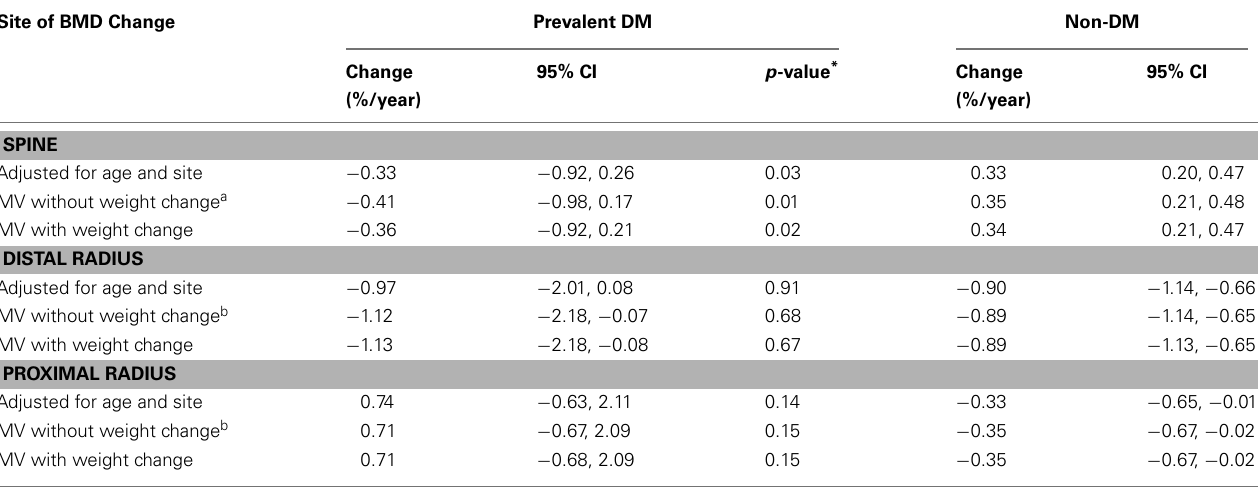
Table 3 |Adjusted mean BMD change at the spine and radius by diabetes